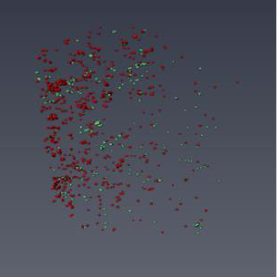
Figure 20. Y56 – 19 core after CO 2 flooding (red is the distribution of crude oil and yellow is the in- jected CO 2 ).